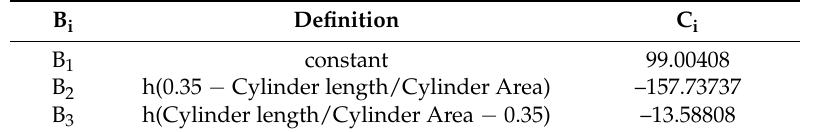
Table 4. List of basis functions of the MARS model number two and their coefficients for feed into the vortex.